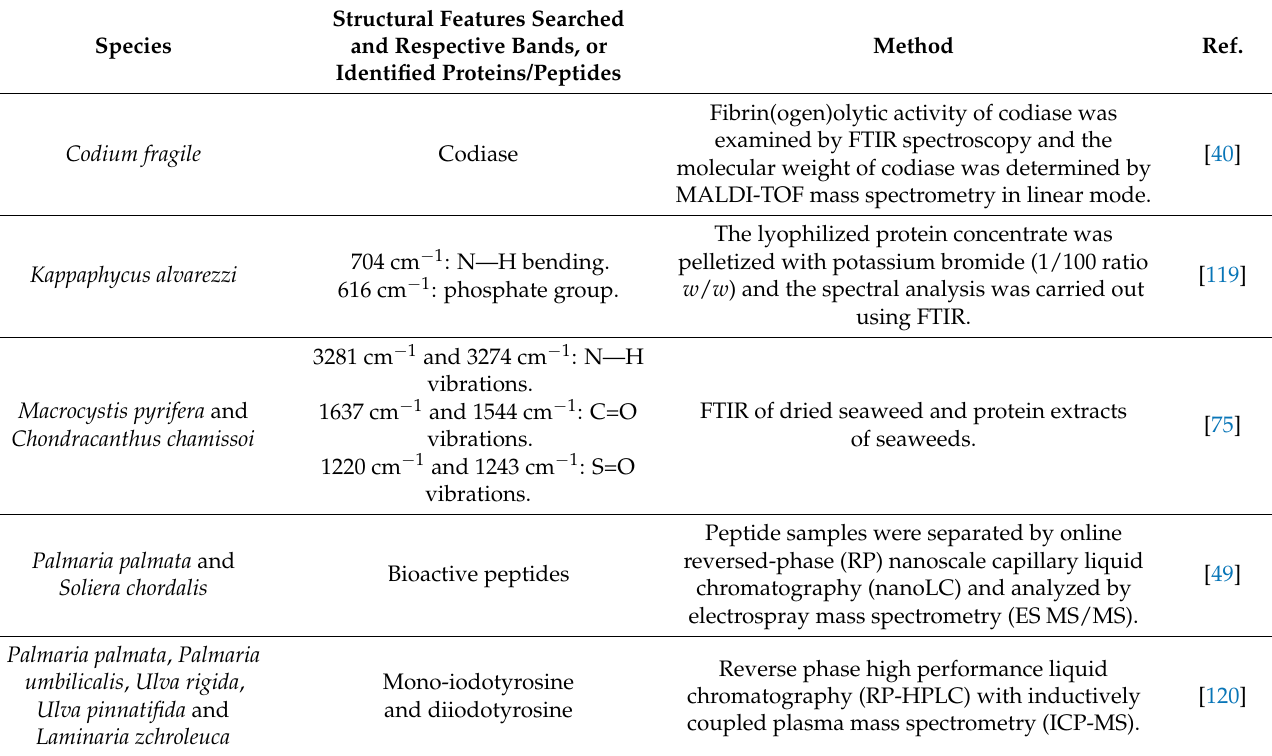
Table 7. Protein characterization using spectrometry methods in different seaweed